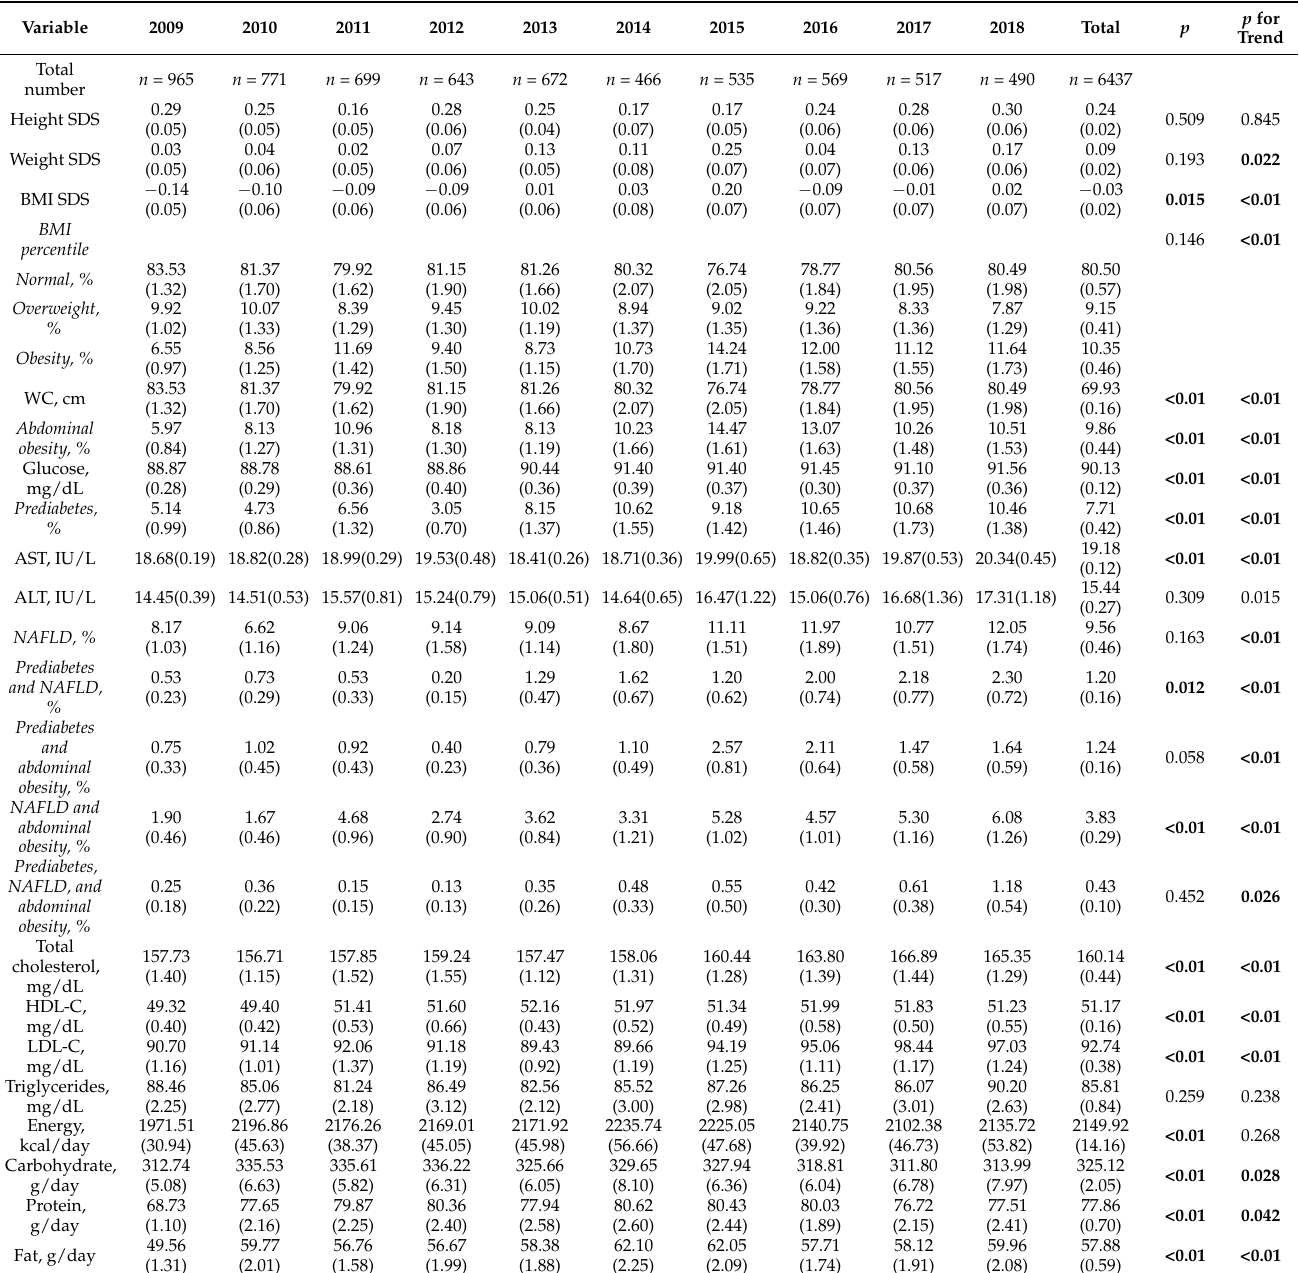
Table 1. Trend of characteristics of